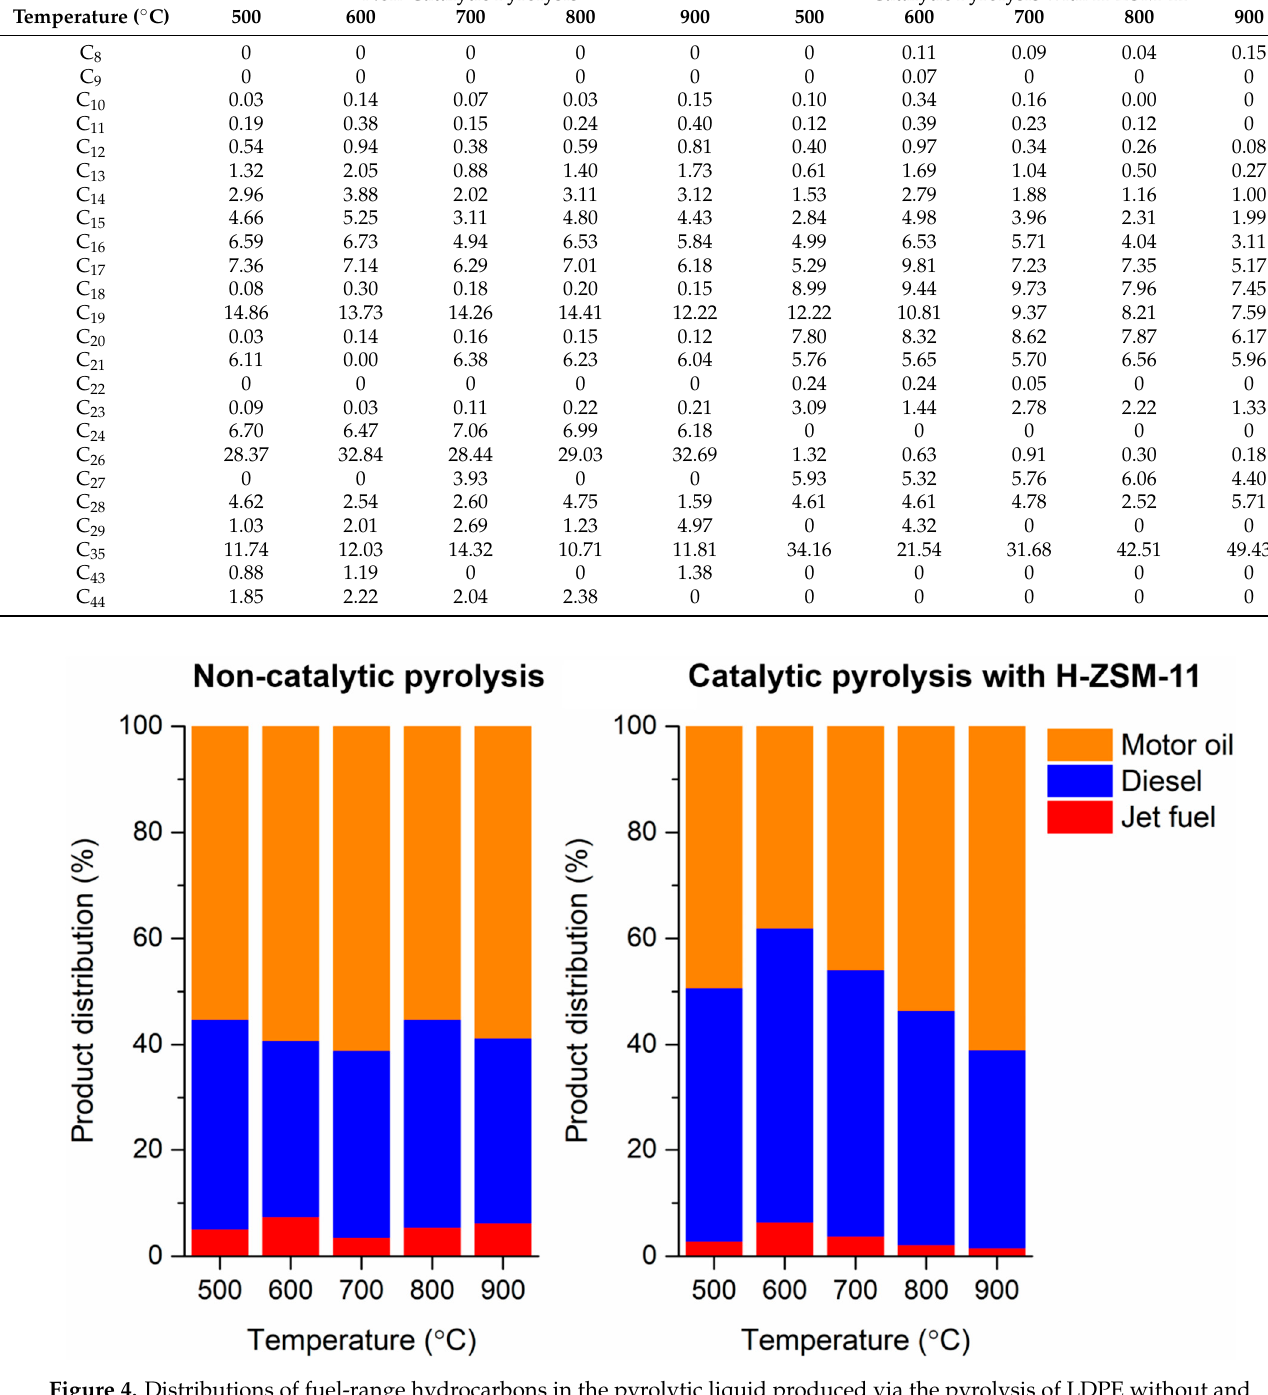
Figure 4. Distributions of fuel-range hydrocarbons in the pyrolytic liquid produced via the pyrolysis of LDPE without and with the H-ZSM-11 catalyst as functions of pyrolysis temperature. Average values of triplicates ( n = 3) are reported and standard deviations of the average values of around 3–6%. Table 2. Yields (%) of hydrocarbons with different carbon numbers in the pyrolytic liquid produced via the pyrolysis of LDPE without and with the H-ZSM-11 catalyst as functions of pyrolysis temperature.